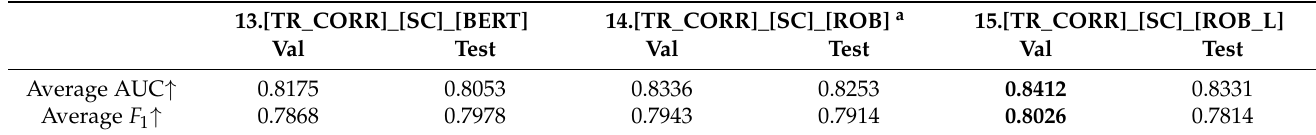
Table 8. Sentiment classification results summary.